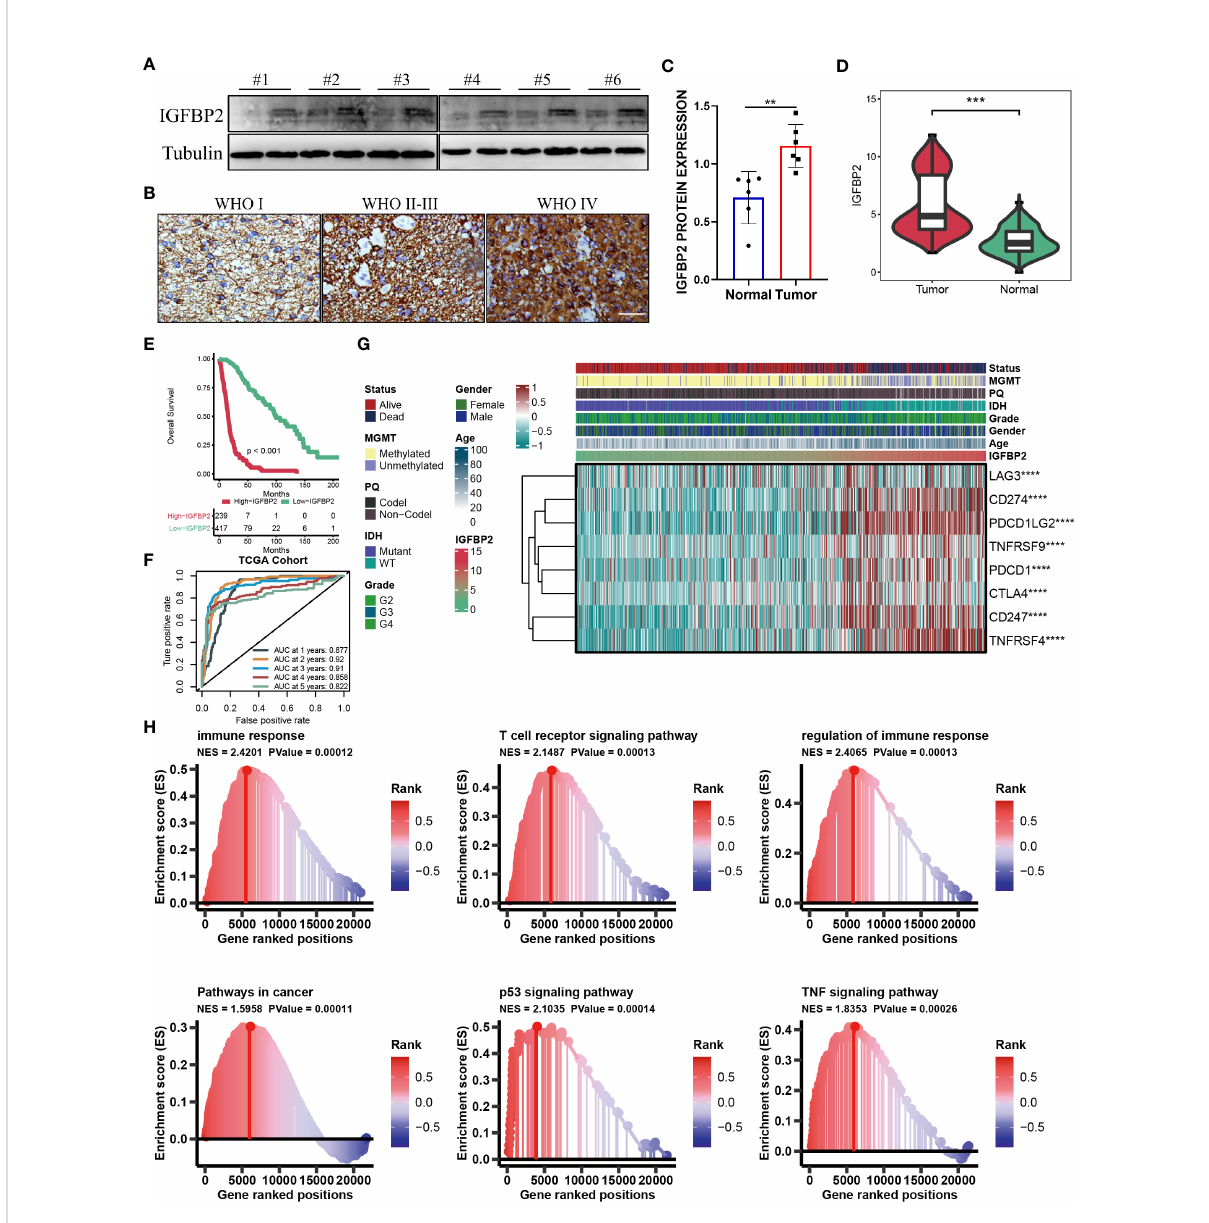
FIGURE 7 (A) WB for IGFBP2 in 3 pairs patients from Nantong cohort. (B) Represented IHC for IGFBP2 in three parents with different WHO stage from Nantong cohort. (C) Boxplot of IHC for IGFBP2 in six pairs parents from Nantong cohort. (D) The expression level of IGFBP2 in glioma sample and the control normal sample. (E) Kaplan-Meier survival curve showing survival probability of high- or low-expression IGFBP2. (F) The 1-year, 2-year, 3-year, 4-year, and 5-year survival ROC curves are predicted by the expression of IGFBP2. (G) The heat map shows the correlation between IGFBP2 and eight immune checkpoints in TCGA. (H) GSEA maps of cancer and immune-related signaling pathways positively modulated by IGFBP2. ∗∗ P < 0.01; ∗∗∗ P < 0.001; ∗∗∗∗ P <